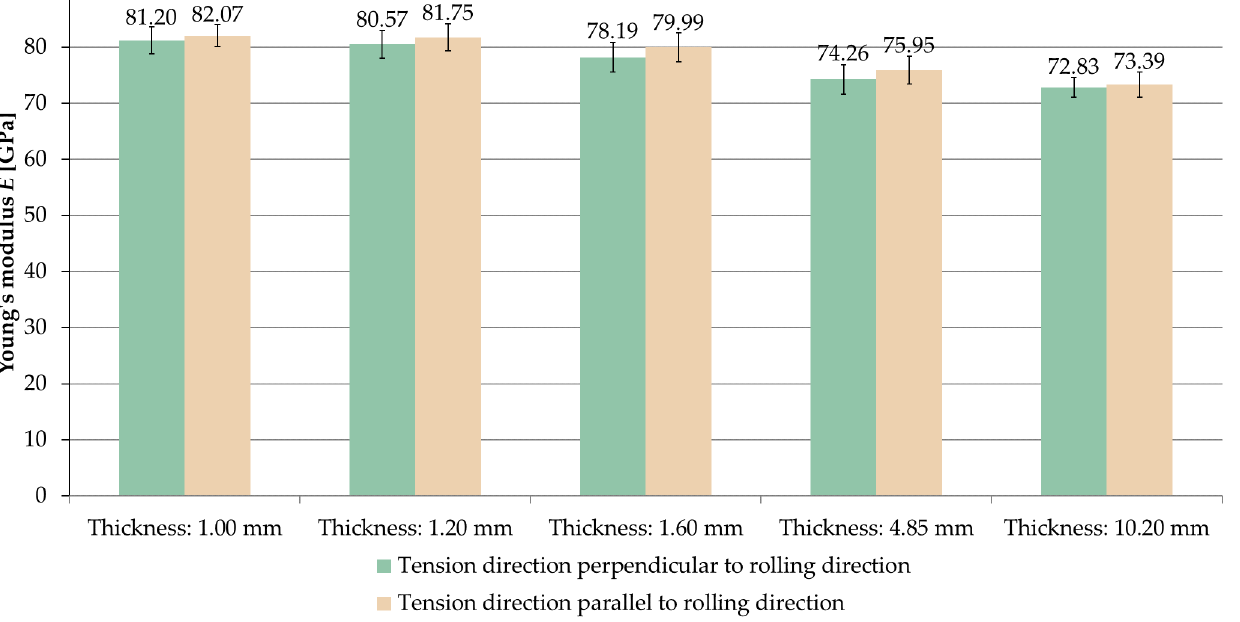
Figure 5. Young’s modulus E depending on the thickness of the sample and the ratio of the tension direction to the rolling